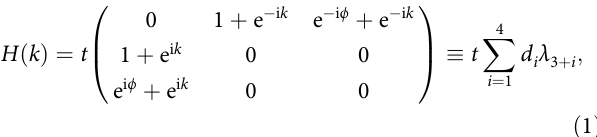
Fig. 1b. The latter case corresponds to the Aharonov – Bohm caging effect, where the particles become immobile due to destructive interference 20 – 22 .